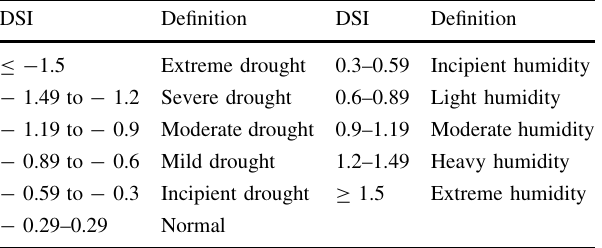
Table 2 Drought categories by drought severity index (DSI)